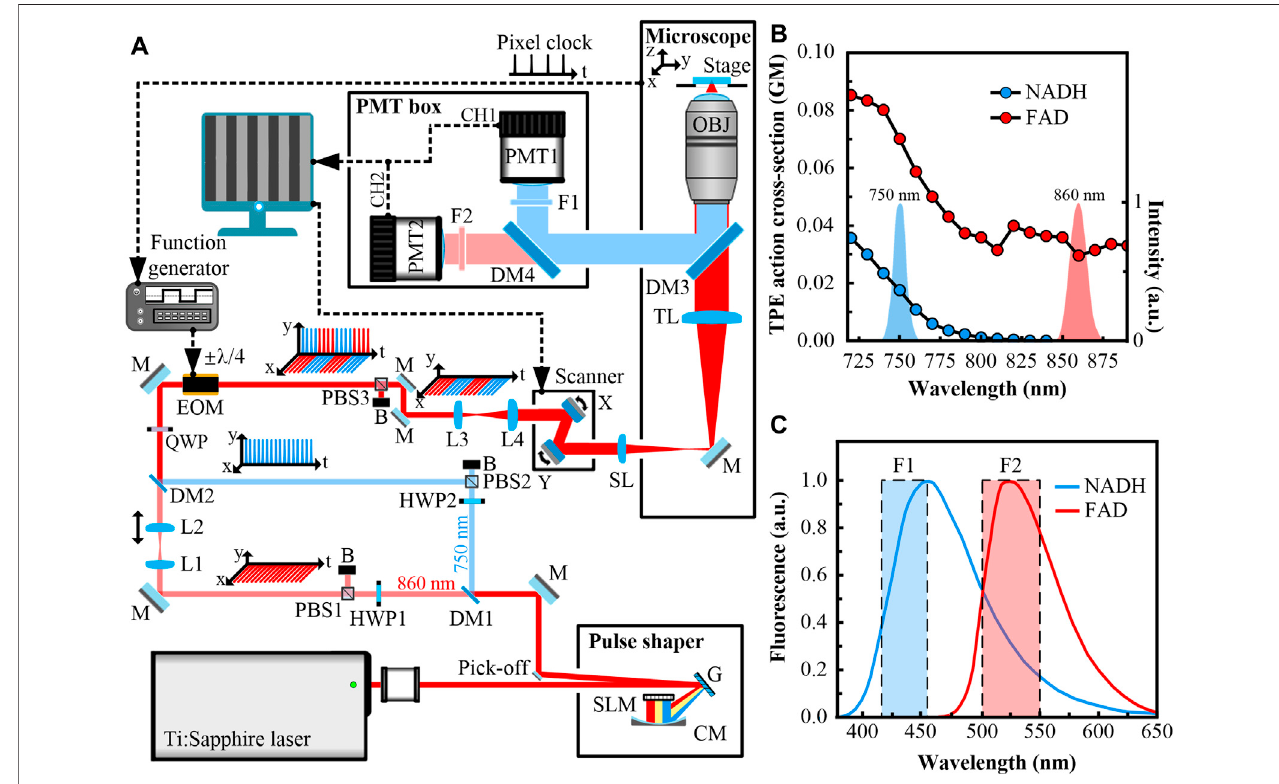
FIGURE 1 | (A) Experimental setup of the simultaneous two-photon fl uorescence (TPF) microscopy of NADH and FAD. The laser beams are mainly shown in red, except that the 750-nm beam is shown in blue. Signals collected by CH1 are indicated in blue, and those collected by CH2 are indicated in red. The electrical paths are depicted in dashed black lines. HWP1, HWP2, half-wave plates; SLM, spatial light modulator; G, grating; CM, concave mirror; M, mirror; DM1, DM2, DM3, DM4, long pass dichroic mirrors; PBS1, PBS2, PBS3, polarizing beam splitters; B, blocker; L1, L2, L3, L4, lenses; QWP, quarter-wave plate; EOM, electro-optic modulator; SL, scan lens; TL, tube lens; OBJ, objective; F1, F2, bandpass fi lters; PMT1, PMT2, photomultiplier tubes. This fi gure is not to scale. (B) Spectra of shaped pulses overlaid with two-photon excitation (TPE) action cross-section spectra of reduced nicotinamide adenine dinucleotide (NADH) and fl avin adenine dinucleotide (FAD). The cross-section is shown in GM unit (1 GM (cid:1) 10 − 50 cm 4 · s · photon − 1 · molecule − 1 ). The spectra show that both substances can be excited at 750 nm, but only FAD can